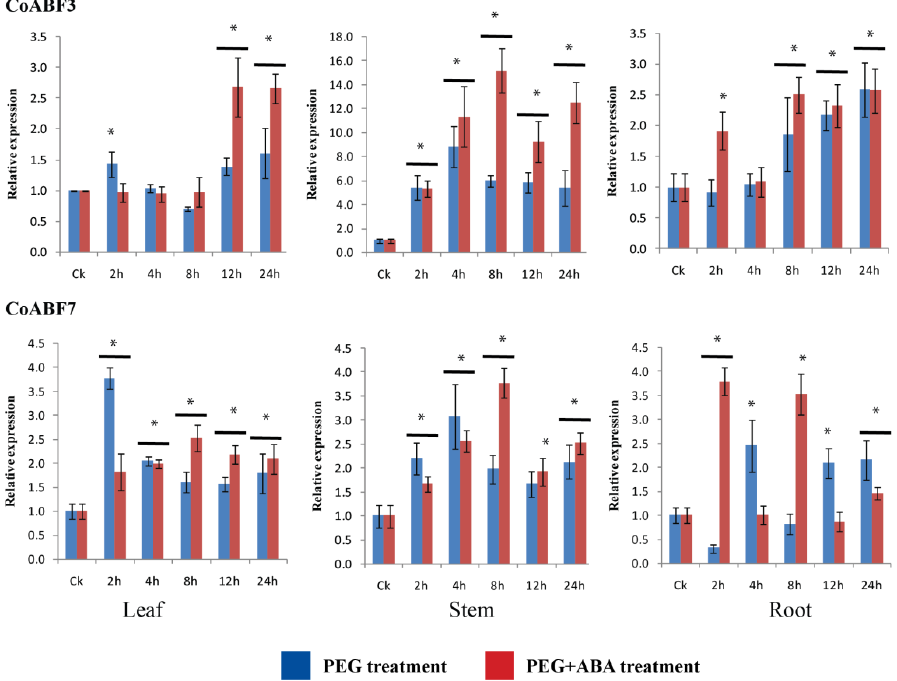
Figure 6. Expression patterns of CoABF3 and CoABF7 , measured in jute tissues under PEG (10 mM), and PEG+ABA (10 mM PEG + 25 µmol/L ABA). Data represent the means of three independent replicates ± standard deviation (SD). Asterisks denote statistically significant differences (* p ≤ 0.05) compared to the control (CK), respectively.